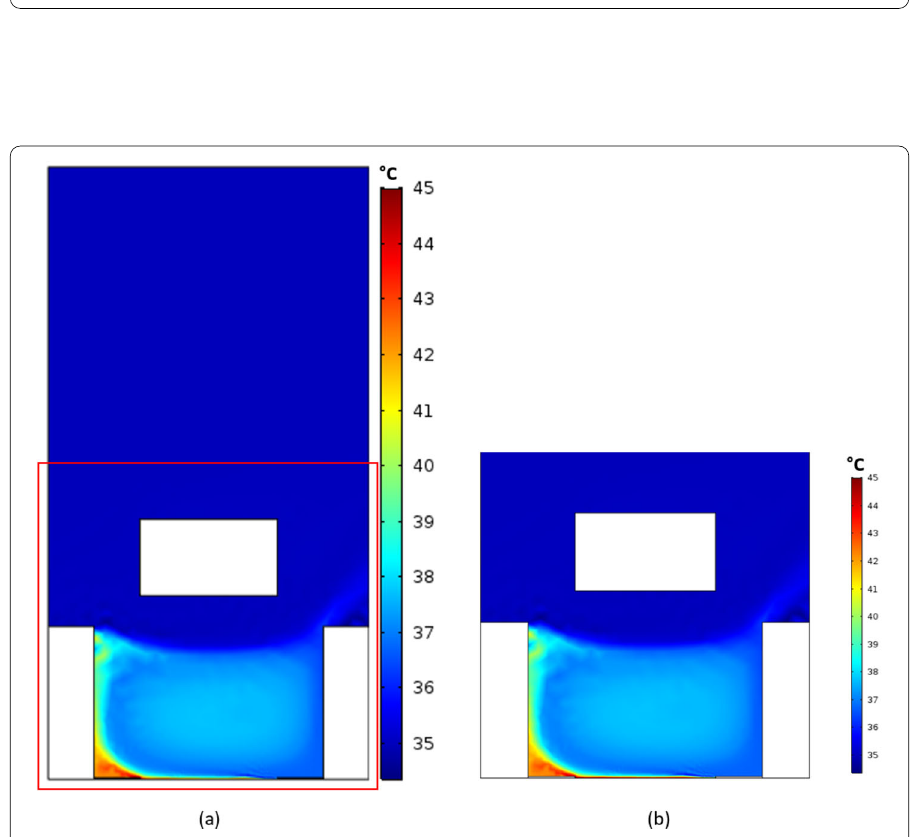
Figure 2 The surface temperature ( ° C) at steady state when u = 7 km/h (gentle wind): ( a ) The entire computational domain, and ( b ) Zoom-in of the selected